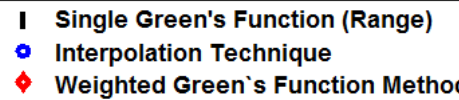
Figure 14. A plot to show the relative performance of the various implementation methods (using R 2 ).